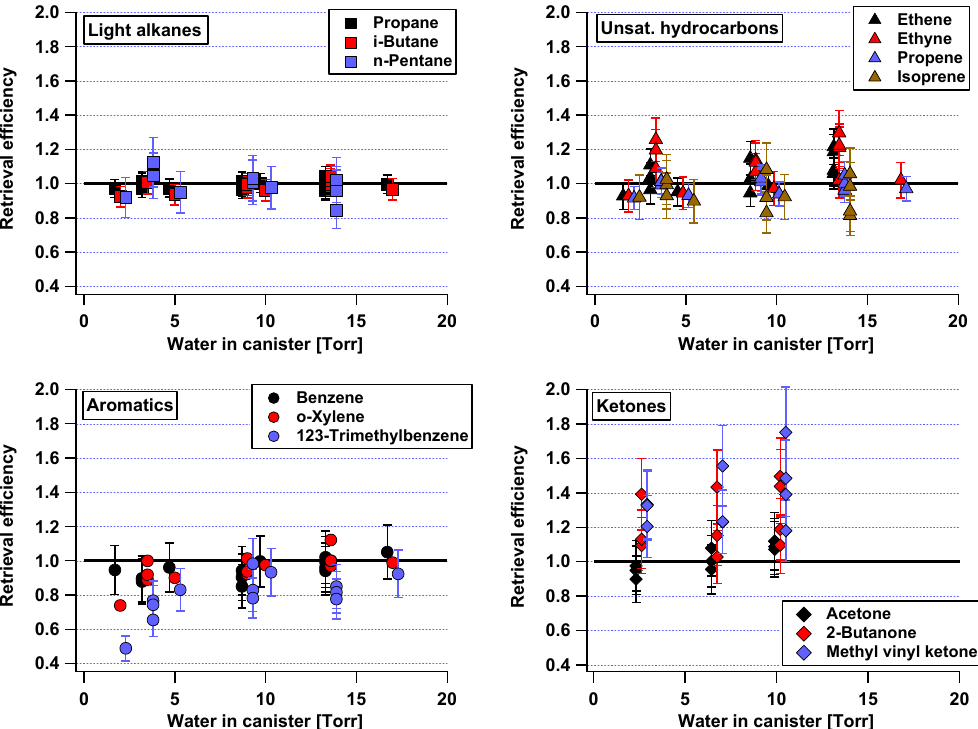
Figure 7. Retrieval efficiency as a function of added water vapor to sample canisters after cleaning. Data points are the ratio of observed mixing ratios in canister samples versus ambient mixing ratios measured by ACCBAR during the time period the canisters were filled. Error bars indicate standard deviation of multiple canisters filled simultaneously. Data are offset on x axis for easier viewing.